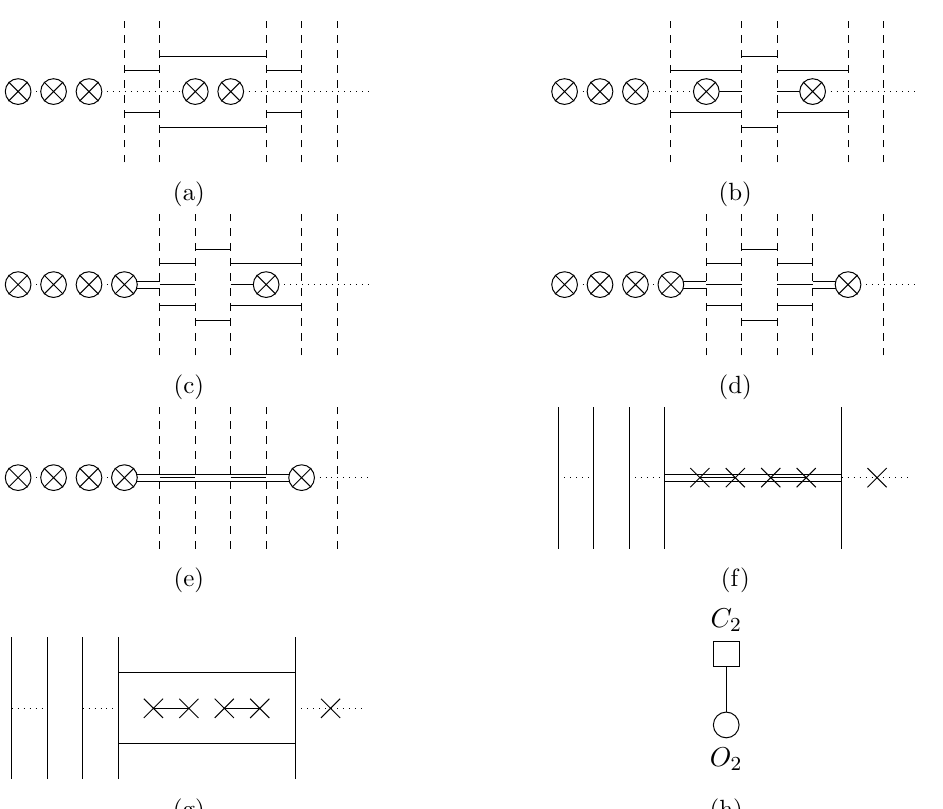
Figure 43. Quiver whose Higgs branch is M H = (cid:22) O (cid:26) sp (2), the closure of the subregular (2 2 ) nilpotent orbit of sp (2). The interval numbers of the half NS5-branes are ~k s = (0 ; 0 ; 0 ; 2 ; 2), corre- sponding to partition (cid:21) t = (2 2 ). (a) Higgs branch. (b-f) One step phase transitions to the Coulomb branch. (g) Coulomb branch. (h) Quiver.